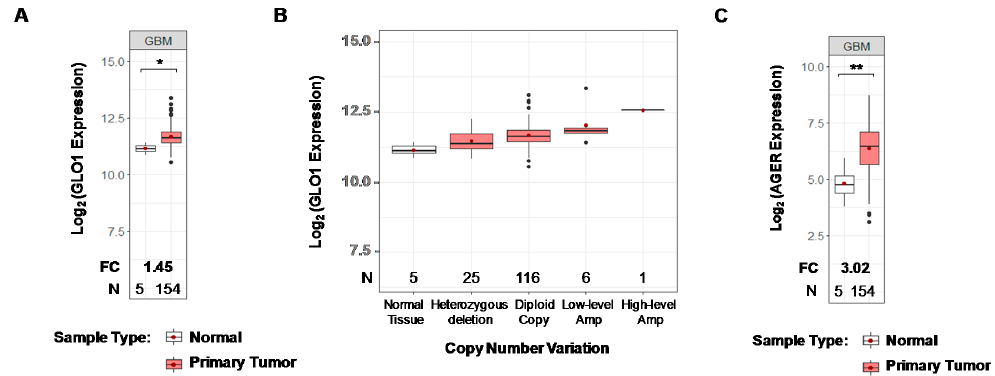
Figure 1. Glyoxylase 1 (GLO1) and RAGE up-regulation in GBM. ( A ) Analyses of TCGA